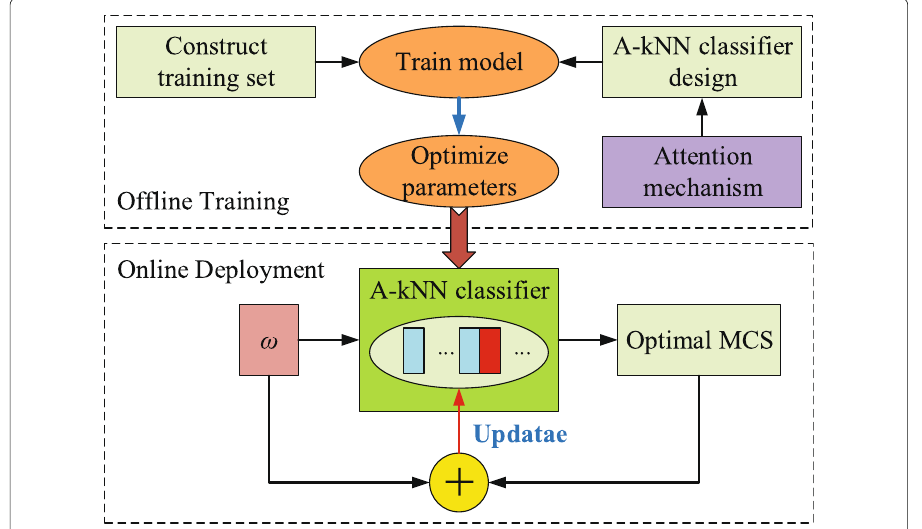
Fig. 5 System architecture of the A- k NN-based